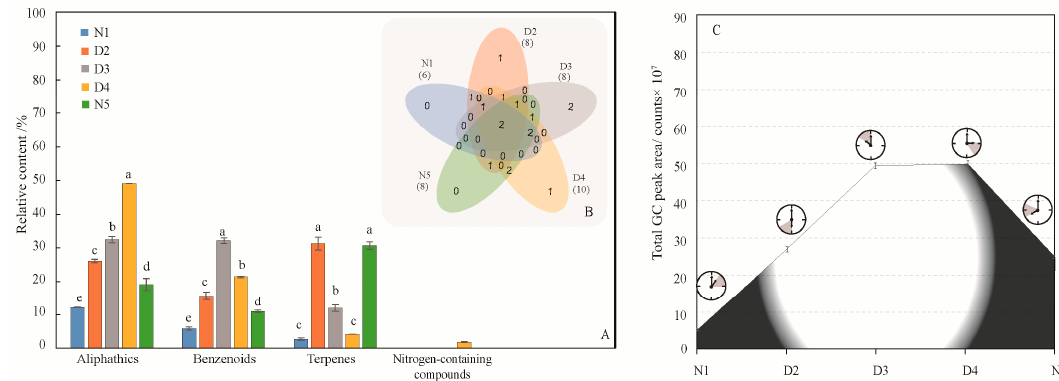
Figure 3. Generation of volatile compounds from M . ioensis “Prairie Rose” flowers during the day and night. ( A ) Compounds of di ff erent chemical classes during day and night. N1 1:00–3:00, D2 6:00–8:00, D3 10:00–12:00, D4 15:00–17:00 and N5 20:00–22:00. The same letters above di ff erent color column mean there is no significant di ff erence in the same chemical class among di ff erent time periods ( P > 0.05), and di ff erent letters indicate significant di ff erence ( P < 0.05). ( B ) Venn diagram indicating the similarities and di ff erences in total volatile compounds among the di ff erent flowering stages. The numbers in related overlapping areas indicate the compounds shared between the di ff erent times. ( C ) Volatile compounds emission from M . ioensis “Prairie Rose” flowers during day and night.